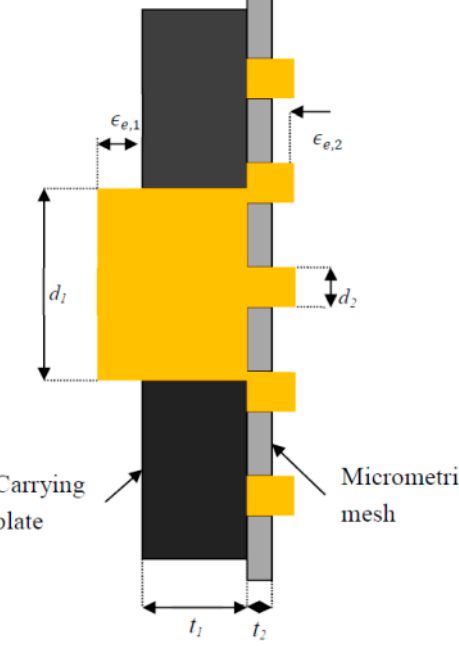
Figure 18. Boundary conditions at the MIU interface.